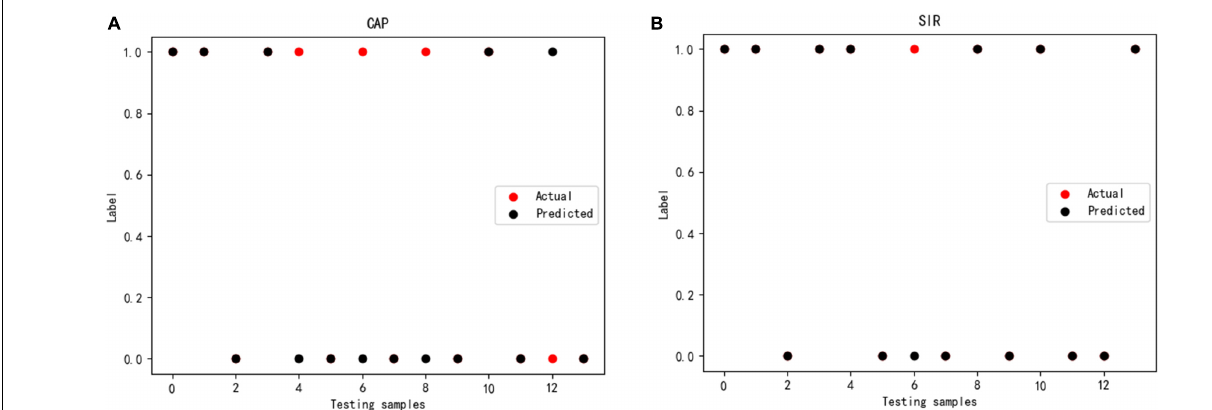
FIGURE 9 | Prediction using SVM classifier for (A) CAP and (B) SIR.